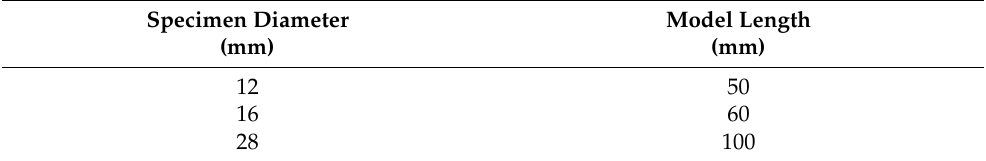
Table 1. Distribution of the model lengths for